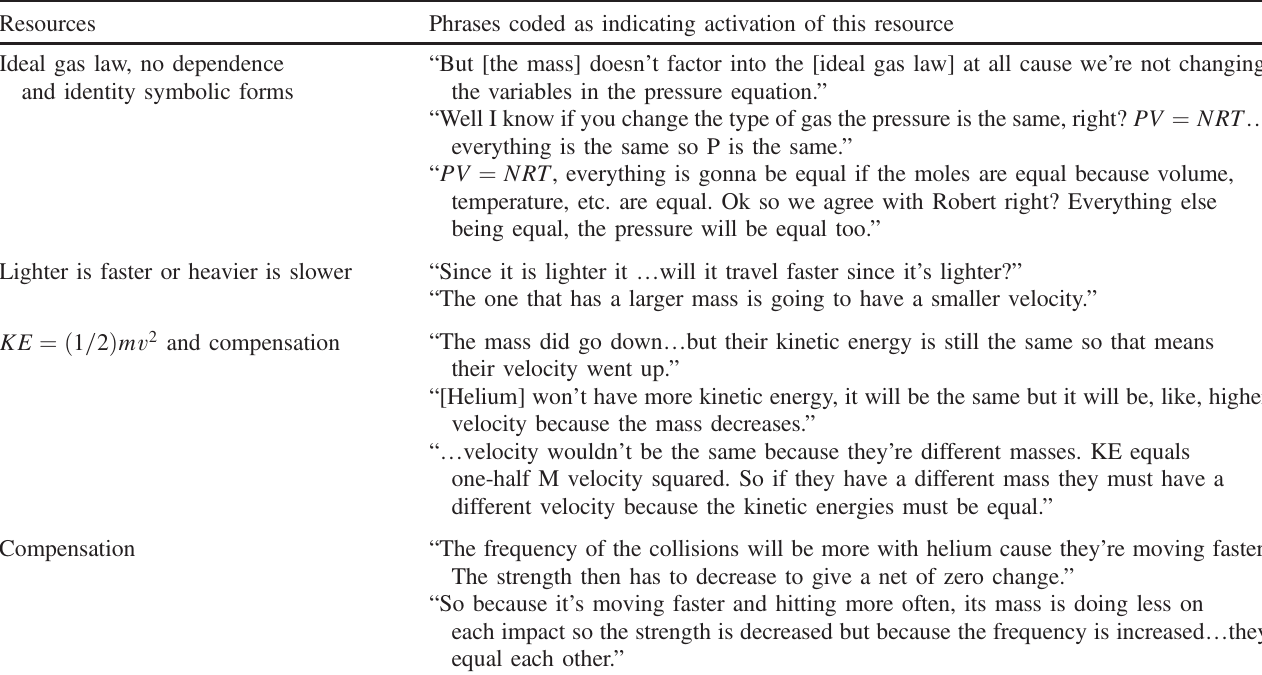
TABLE III. Evidence for resources used in the changing gas problem. Resources Phrases coded as indicating activation of this resource